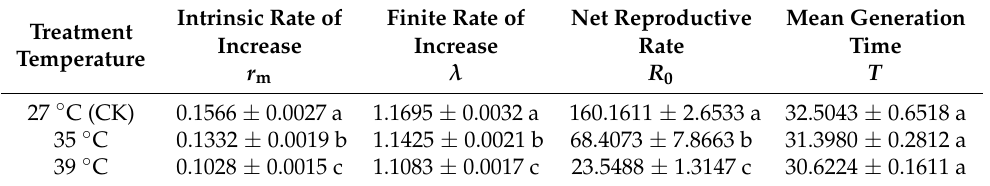
Table 6. Demographic parameters of Leptinotarsa decemlineata after the adults were exposed to different high temperature (27 ◦ C, 35 ◦ C and 39 ◦ C). Data are expressed as mean ± SE. Data followed by the same letter in the same column are not significantly different ( p >